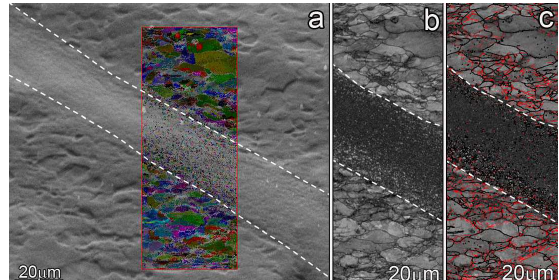
Fig. 4. EBSD images of TBs in zirconium alloy deformed at a strain of 0.30 and a strain rate of 2300 s -1 : (a) indexed zone of TBs, (b) band contrast image of TB, (c) grain boundary image of TB. High and low angle boundaries are depicted as black and red lines.